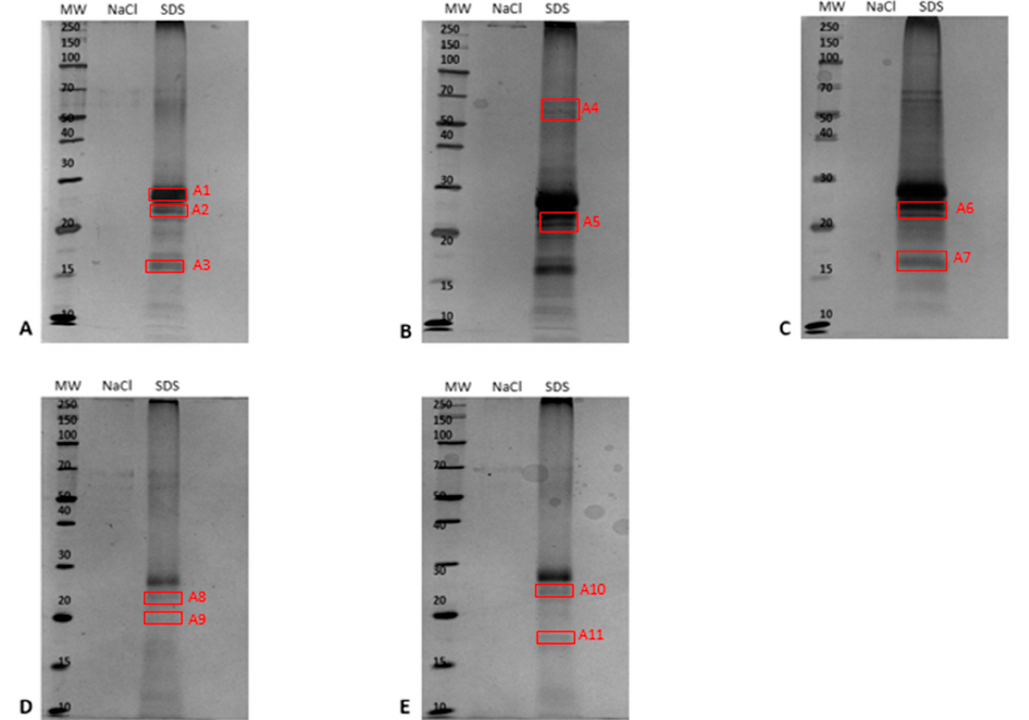
Figure 6. Comparative 12% 1D-SDS-PAGE analysis of ergosterol-interacting candidate proteins eluted with 0.5 M NaCl and 1% SDS during the affinity-capture procedure using EAH Sepharose 4B resin, where A = control, B = 0 h-, C = 6 h-, D = 12 h-, and E = 24 h-treated samples. For each fraction, 20 µ g total protein was loaded and electrophoresed at constant 90 V at room temperature. The red blocks (A1–A11) were excised subsequent to silver staining and analyzed using LC-MS/MS for protein